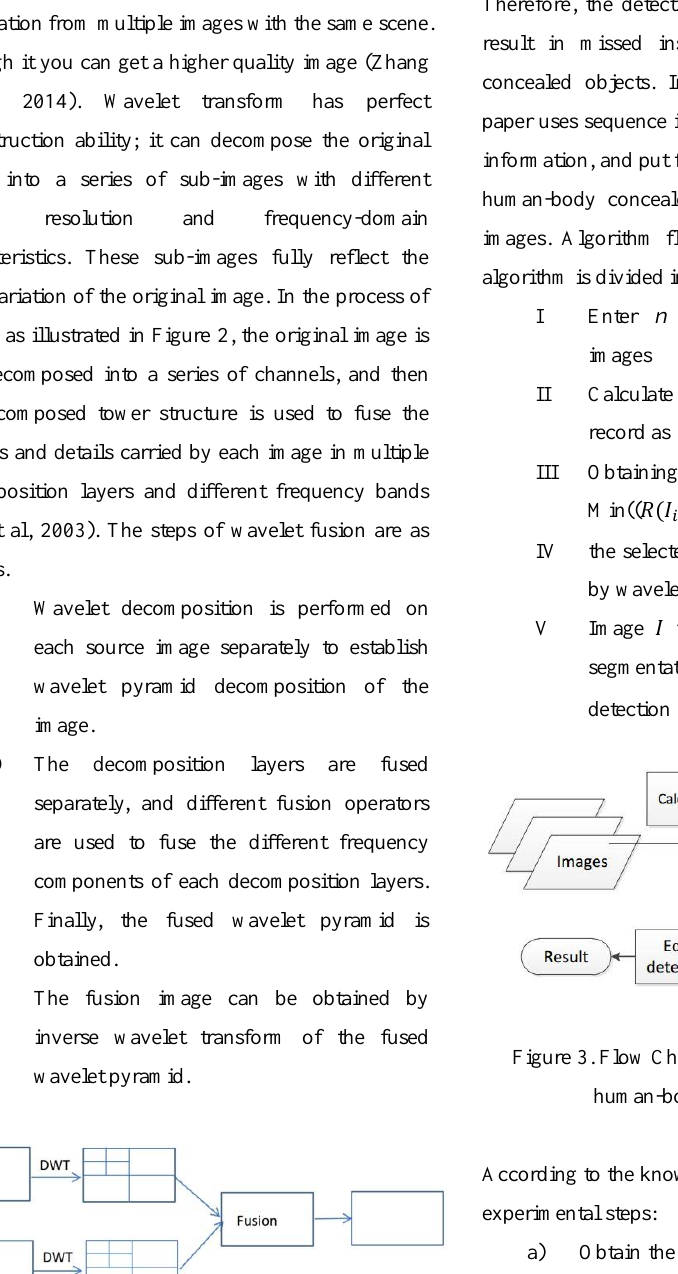
Figure 2. Schematic of wavelet fusion 3. THE DETECTION ALGORITHM OF CONCEALED OBJECT OF PMMW SEQUENCE IMAGES